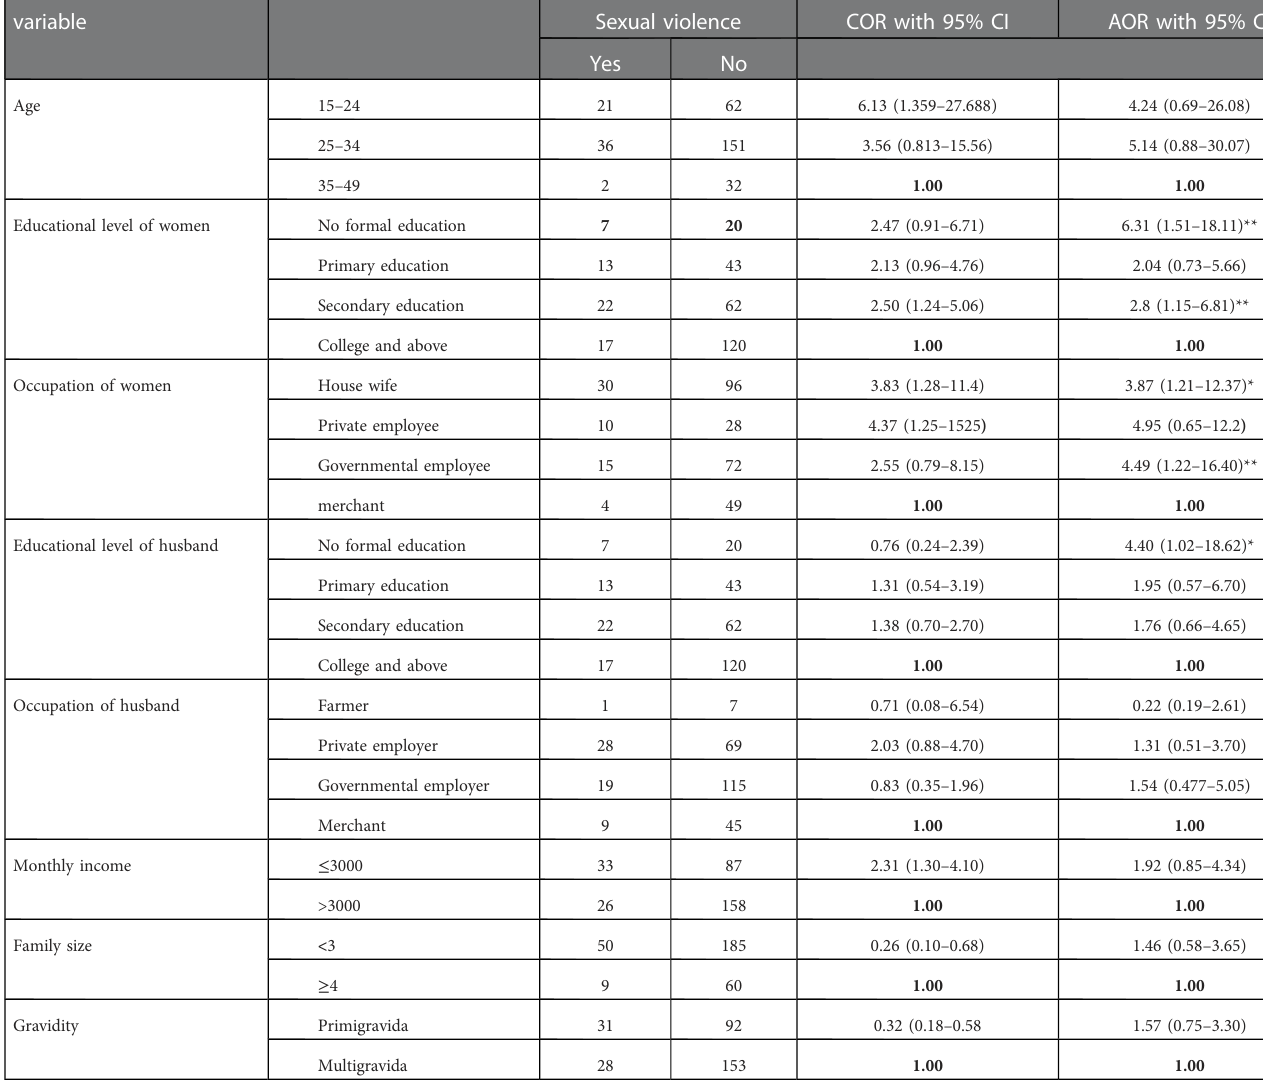
TABLE 3 Factors associated with sexual violence among pregnant women attending ANC at Debre Markos in public institution of, Debre Markos, Ethiopia, 2021 ( n =304).